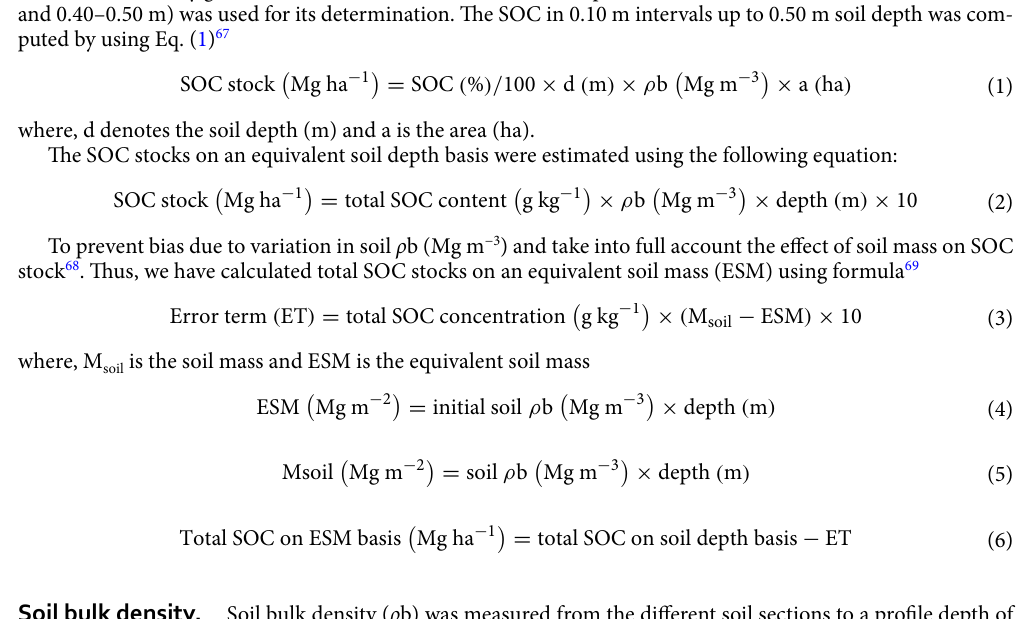
method 63 . The finely ground and sieved soil from the different depths (0.0–0.10, 0.10–0.20, 0.20–0.30, 0.30–0.40, and 0.40–0.50 m) was used for its determination. The SOC in 0.10 m intervals up to 0.50 m soil depth was com- puted by using Eq. (1) 67